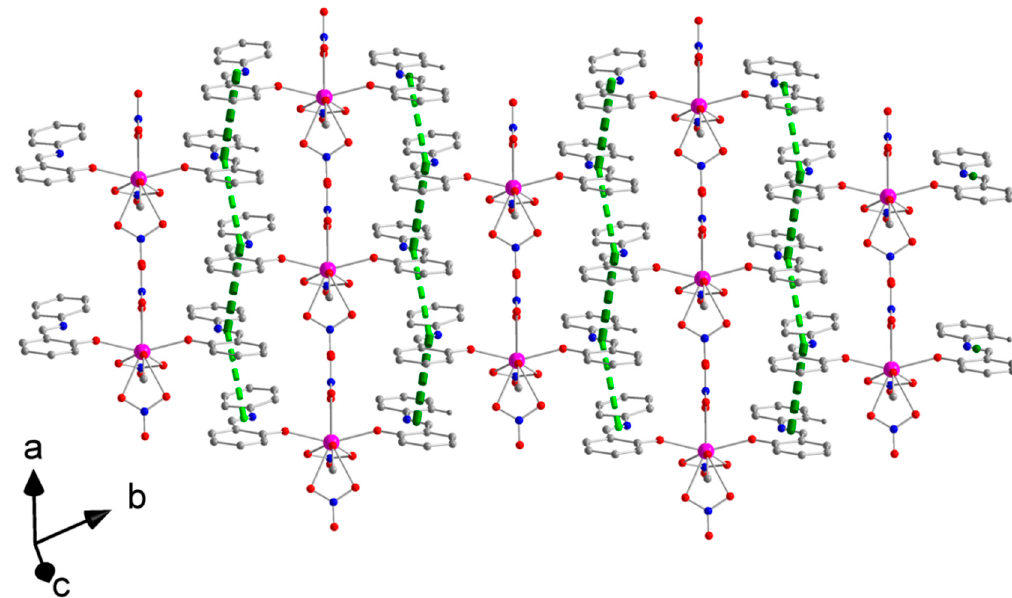
Figure 9. A brick wall-type layer of the [Dy(NO 3 ) 3 (salanH) 2 (MeOH)] molecules parallel to the (001) plane in the crystal structure of 18 _Dy. The dashed dark green and light green lines indicate the two types of intermolecular π - π interactions between coordinated salanH ligands.